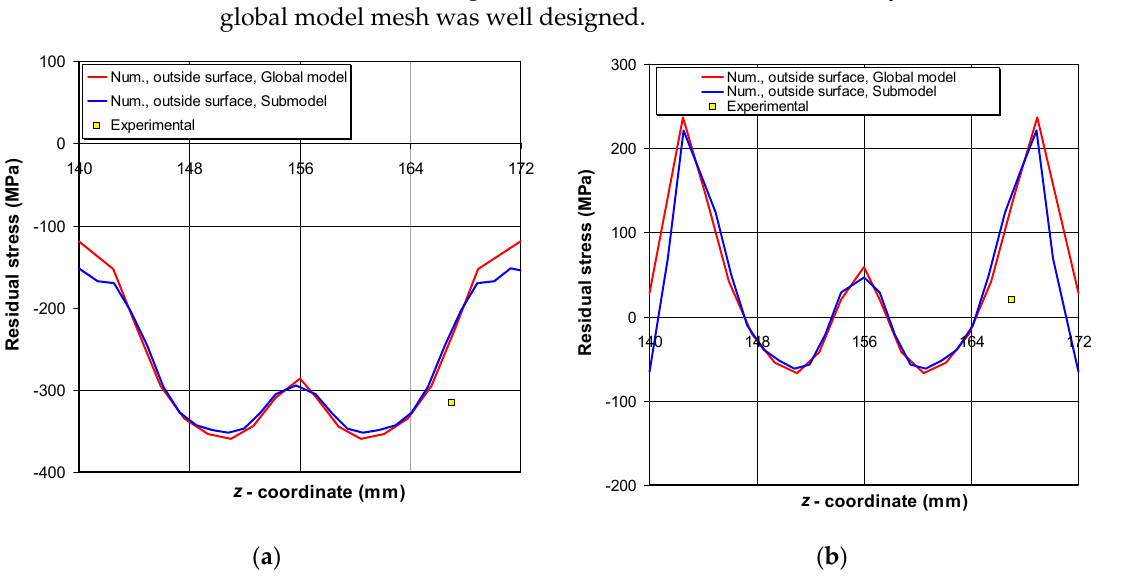
Figure 7. Residual stress profiles of global model and submodel along line z 1- z 2, α = 90°, (Figure 2), ( a ) axial stress, ( b ) hoop stress.